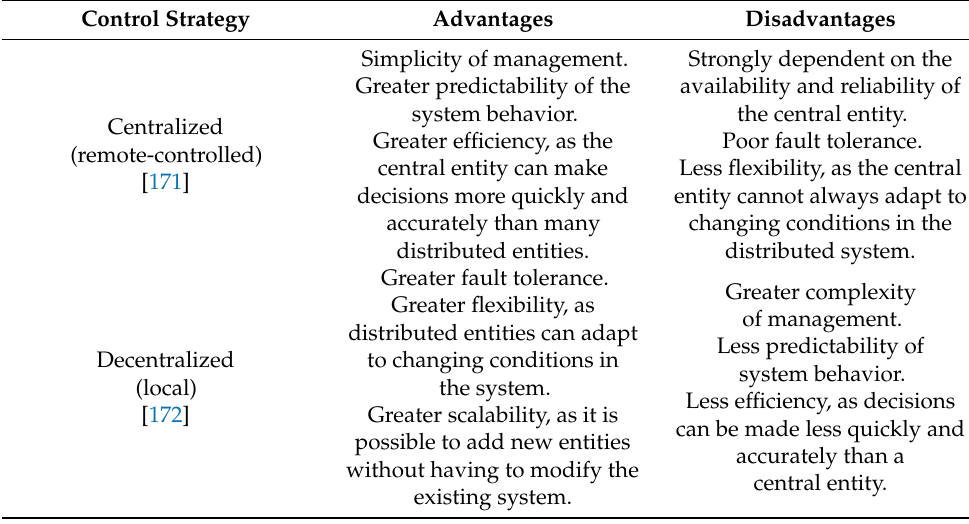
Table 5. Advantages and disadvantages of centralized and decentralized control